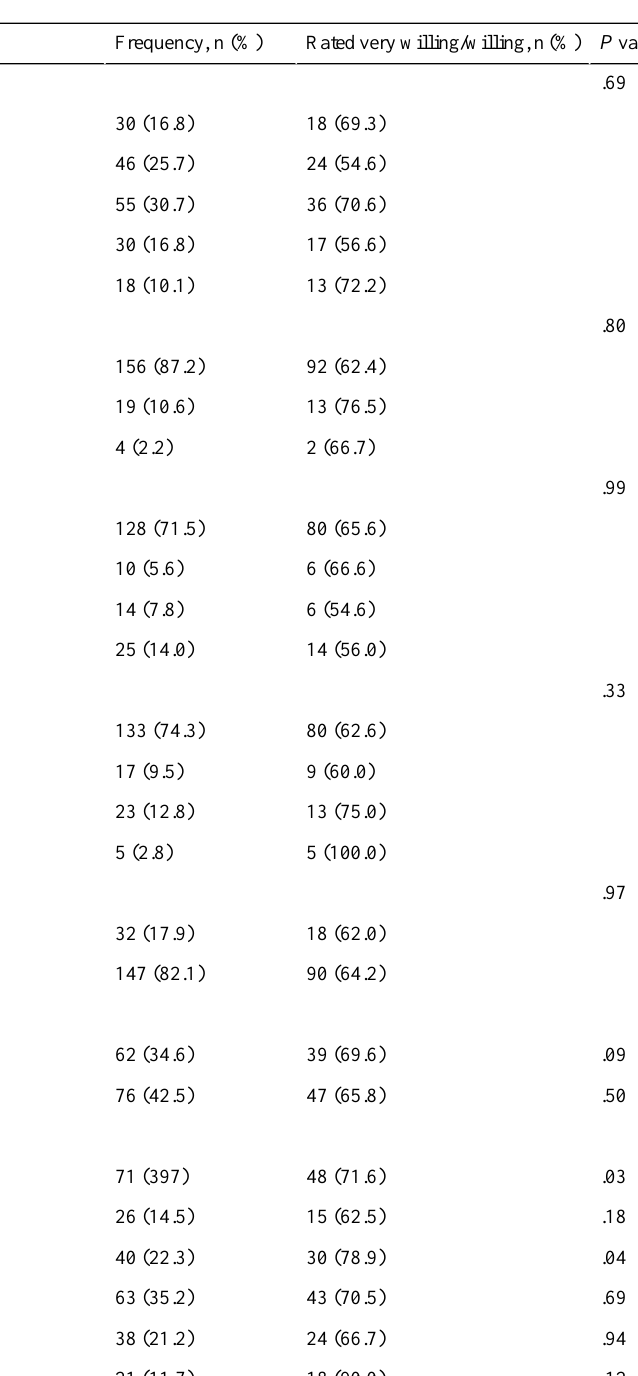
Table 1. Willingness to use an app for HIV testing reminders among HIV-negative men who have sex with men recruited from a popular social-networking app in London